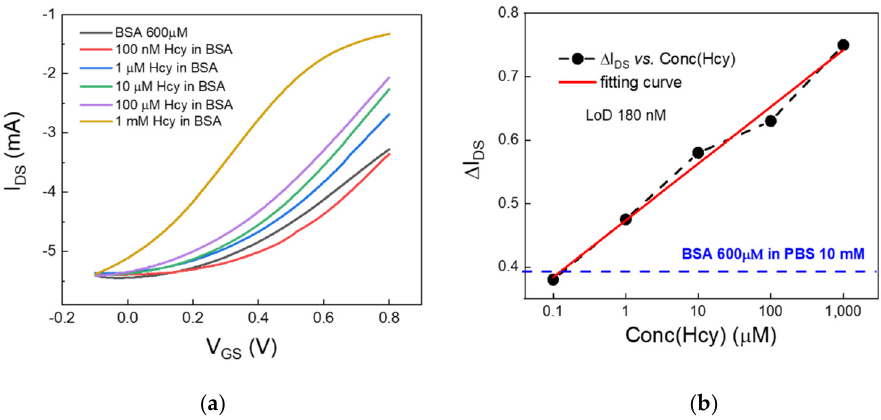
Figure 5. ( a ) OECT transfer curves measured with a platinum electrode in albumin-based solu- tions (at a fixed BSA concentration of 600 μ M) at different Hcy concentrations (from 100 nM to 1 mM). ( b ) Lin-log plot of the modulation parameter Δ I DS , extracted from all the recorded transfer curves in panel ( a ), as a function of the Hcy concentration in BSA:PBS solutions. The dashed blue line represents the modulation parameter for the blank measurement (BSA in PBS).